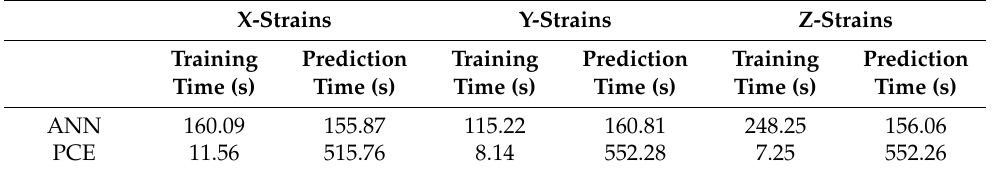
Table 3. Training and prediction time for each model.